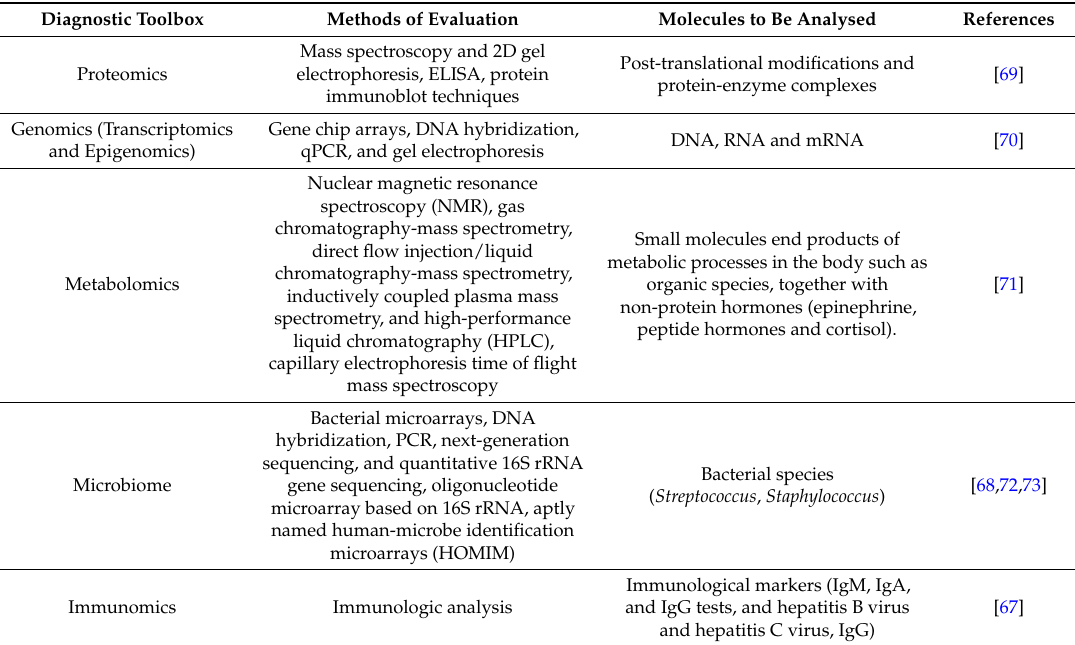
Table 2. Methods used for the evaluation of diagnostic toolboxes.